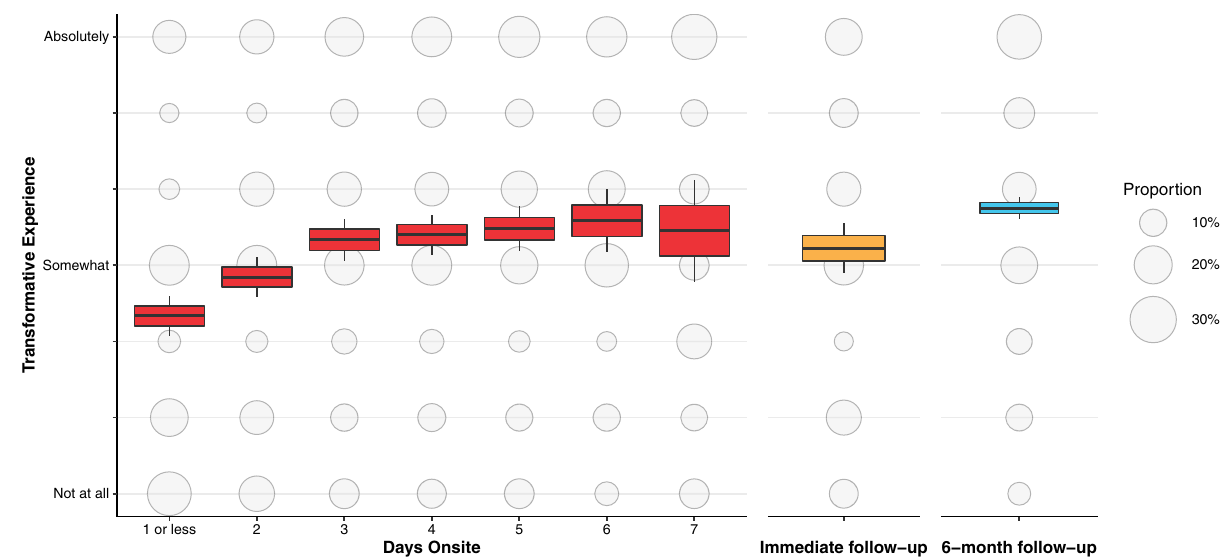
Fig. 2 Self-reported transformative experience increases over time at mass gatherings and persists at least 6 months after attendance ( n = 3081 independent samples examined over 3 separate timepoints in 15 separate studies). Boxplot centers indicate average reported transformative experience at each timepoint; box edges standard error of the mean; whiskers 95% con fi dence interval. Bubbles re fl ect the proportion within each timepoint reporting each level of transformative experience. Source data are provided as a Source Data fi